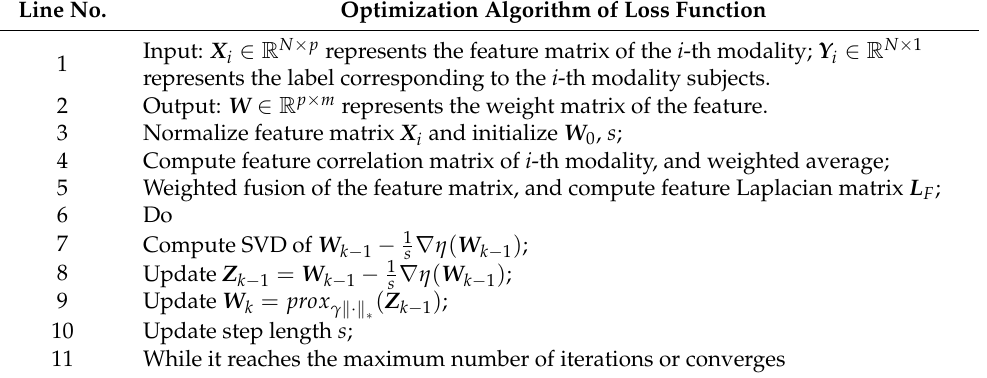
Table 2. Optimization algorithm of loss function. Line No. Optimization Algorithm of Loss